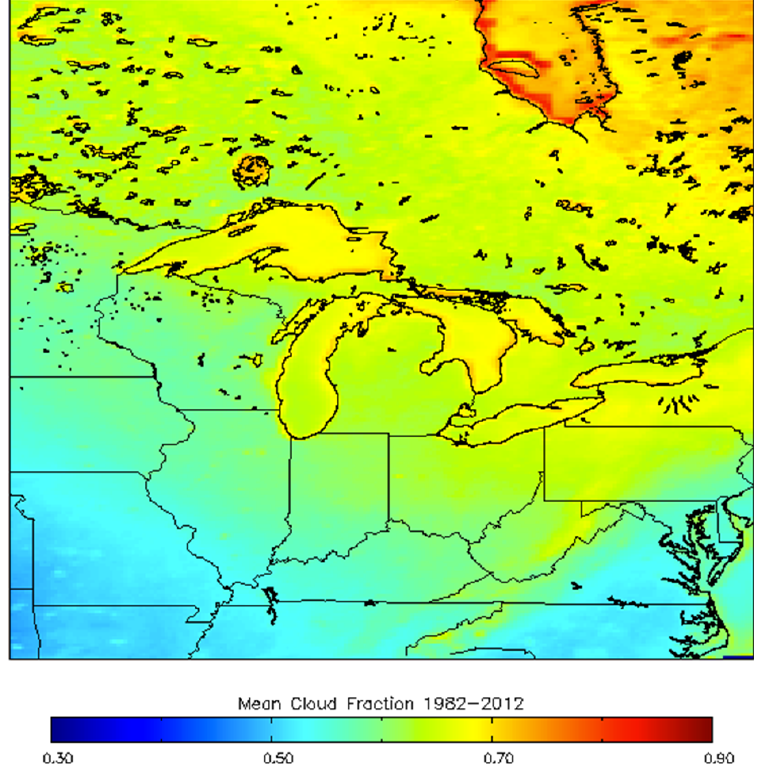
Figure 1. Annual mean cloud amount from AVHRR PATMOS-x from 1982 to